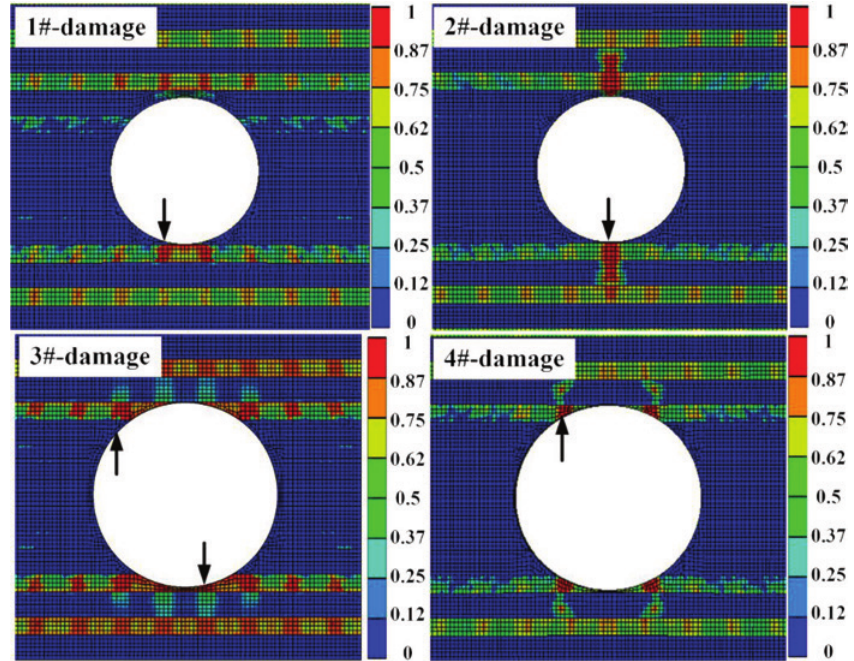
Figure 11: Damage variable